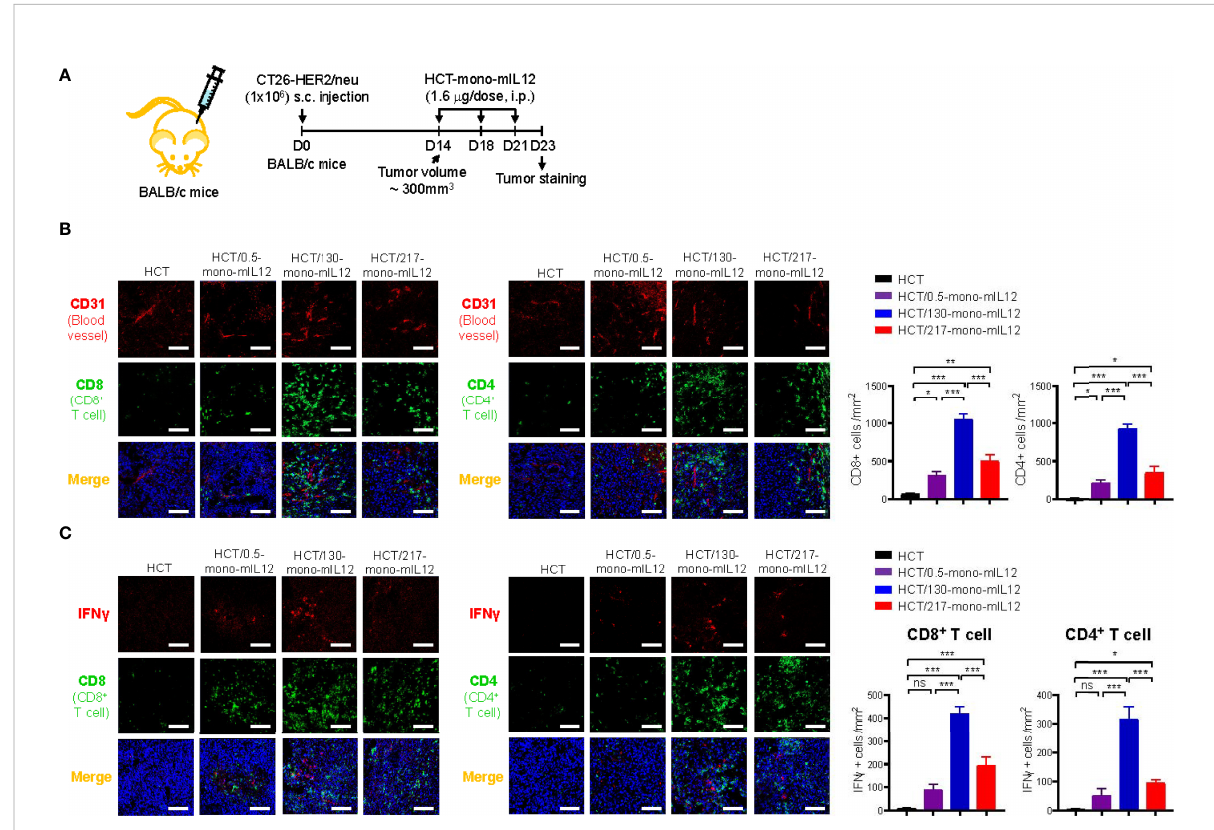
FIGURE 5 Intratumoral distribution of CD4 + and CD8 + TILs correlates strongly with the intratumoral penetration of HCT-mono-mIL12. (A – C) Treatment scheme of CT26-HER2/neu tumor-bearing mice initiated at a tumor volume of ~300 mm 3 with i.p. injection of HCT-mono-mIL12 at 1.6 m g per dose (an equimolar amount of 0.5 m g rmIL12 per dose) three times on day 14, 18, and 21 after tumor inoculation (A) to determine the intratumoral distribution of total CD4 + and CD8 + TILs in relation to the blood vessels (B) and IFN g -producing cells among CD4 + and CD8 + TILs (C) at 2 days after the third dosing determined by IF staining. In (A) , the arrows indicate each time point for treatment or assay. In (B, C) , tumor tissues were excised and stained for CD4 or CD8 (Alexa Fluor 488, green) with CD31 (TRITC, red) (B) and/or IFN g (TRITC, red) (C) . Blue represents nuclei staining. Image magni fi cation, ×200; scale bar, 50 m m. The bar graphs depict the number of the indicated cells per mm 2 in a tumor section. Data represent mean ± SEM of four fi elds per tumor (n = 3 per group). *p < 0.05, **p < 0.01, ***p < 0.001 between the indicated groups; ns, not signi fi